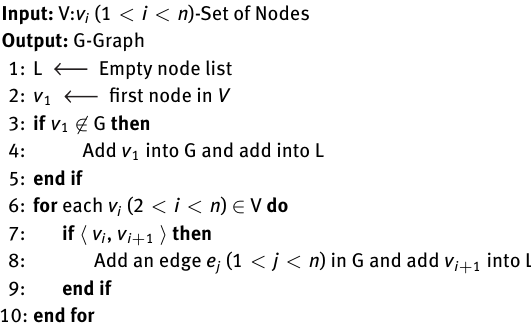
Algorithm 1: FPIG Construction.